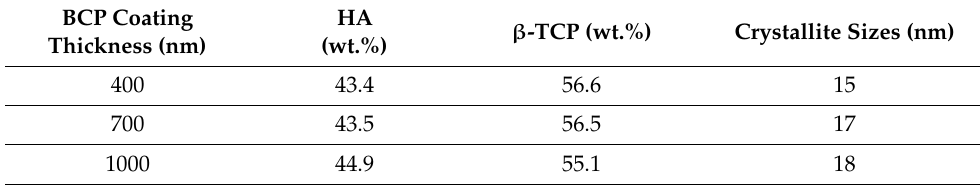
Table 2. HA and β -TCP phase content (wt.%) and crystallite sizes of BCP coatings with various